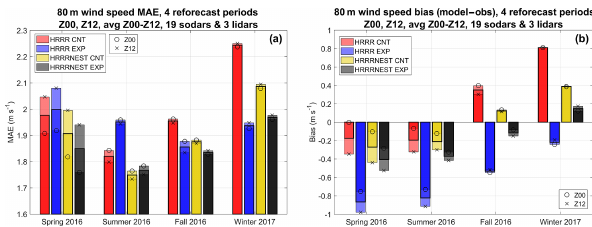
Figure 3. Eighty-meter wind speed MAEs (a) and biases (b) aver- aged over the four reforecast periods. Initialization times are repre- sented by circles (Z00 runs) and by X’s (Z12 runs), while the solid bold lines are the averages between the Z00 and Z12